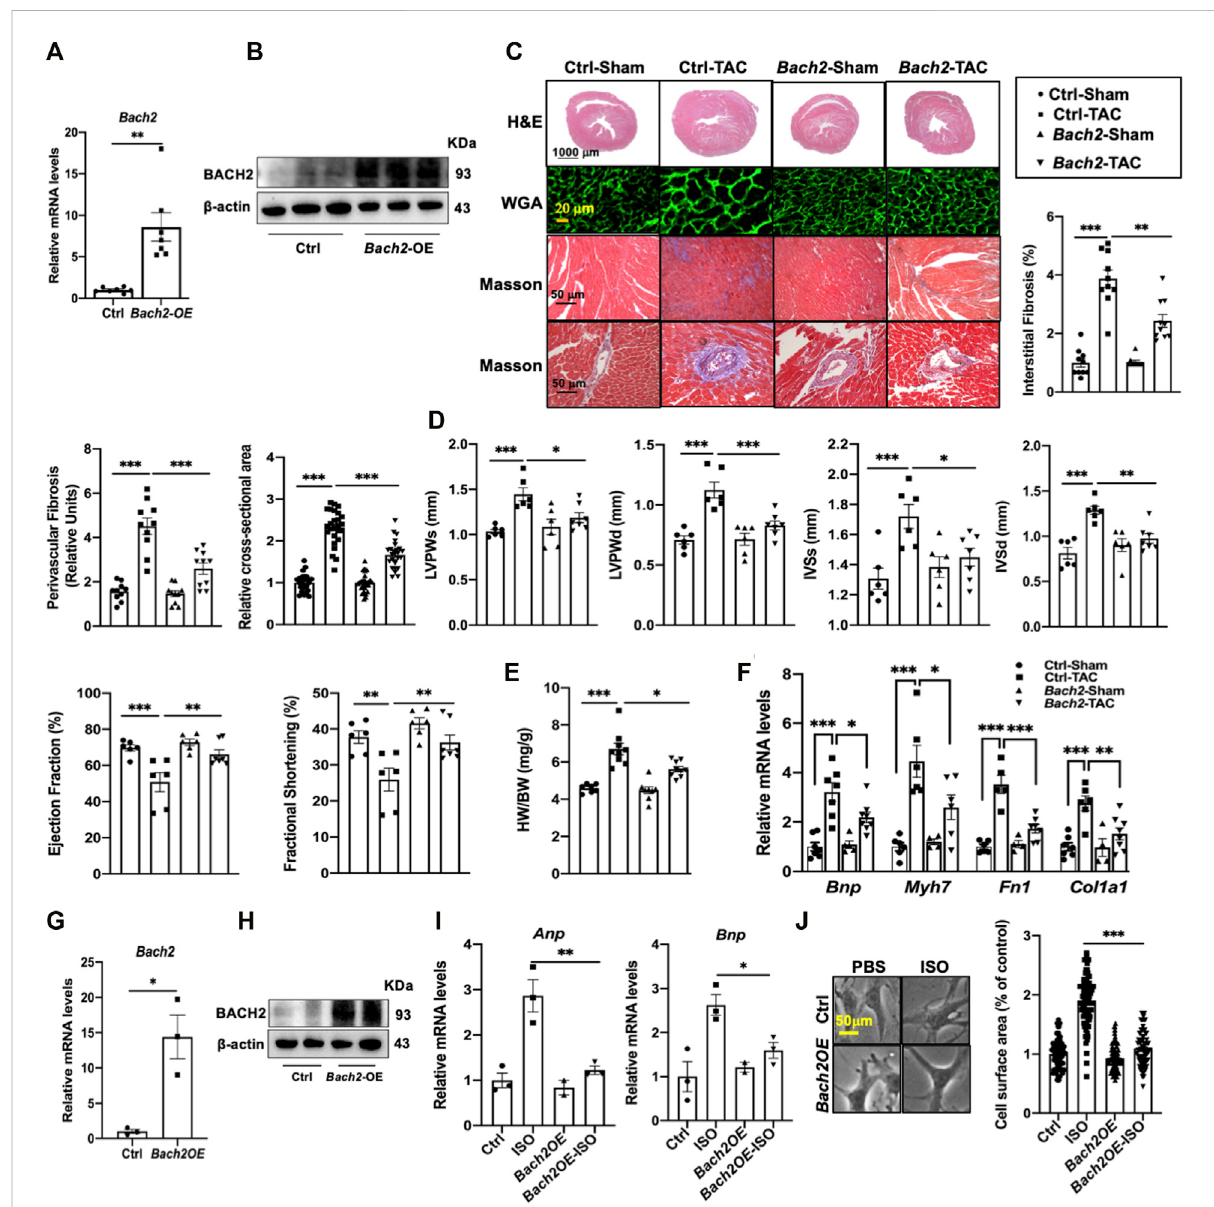
FIGURE 2 BACH2 overexpression attenuatescardiac hypertrophyand failure. (A – B) The relative Bach2 mRNA and protein levels of mouse hearts injected with Bach2 adeno-associated virus 9 (AAV9) or control virus through the tail vein. (C) Histological and quanti fi cation analyses of transverse heart sections. Hematoxylin-eosin (H & E) and wheat germ agglutinin (WGA) showed the hypertrophic cardiomyocytes. Masson stain demonstrated the perivascular(relativetovasculardiameter)andinterstitial fi brosis. (D) Echocardiographicanalysesofcardiacsystolicfunctionandwallthickness. (E) Heart weight/body weight (HW/BW). (F) The mRNA levels of Bnp, Myh 7, Col1a1 and Fnl. (G – H) NRVMs were transfected with lentivirus vector encoding rat Bach2 or control lentivirus for 48 h. (I) Overexpression of BACH2 in NRVMs decreased the mRNA levels of Anp and Bnp after treated with 10 µM ISO for 24 h. (J) Overexpression of BACH2 decreased the cell surface area of NRVMs treated with IO µM ISO for 24 h photographed by bright- fi eld microscope. * P < 0.05, ** P < 0.01, *** P <